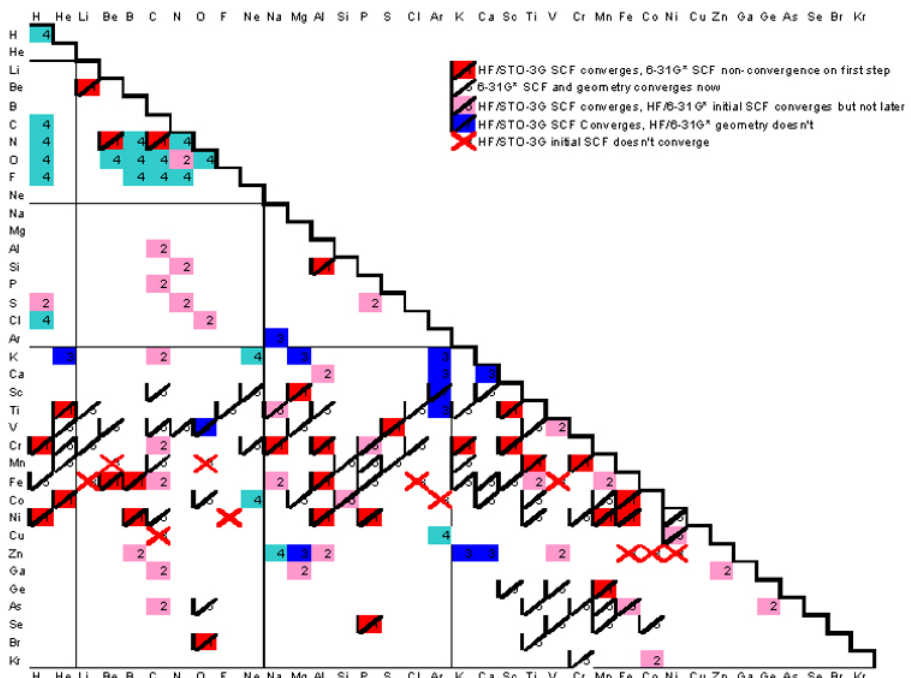
Figure 2. Results of running HF/6-31G* optimization calculations on the Set 1 molecules. A black checkmark indicates the HF/STO-3G SCF calculation was successful. A red X indicates the HF/STO-3G calculation failed to